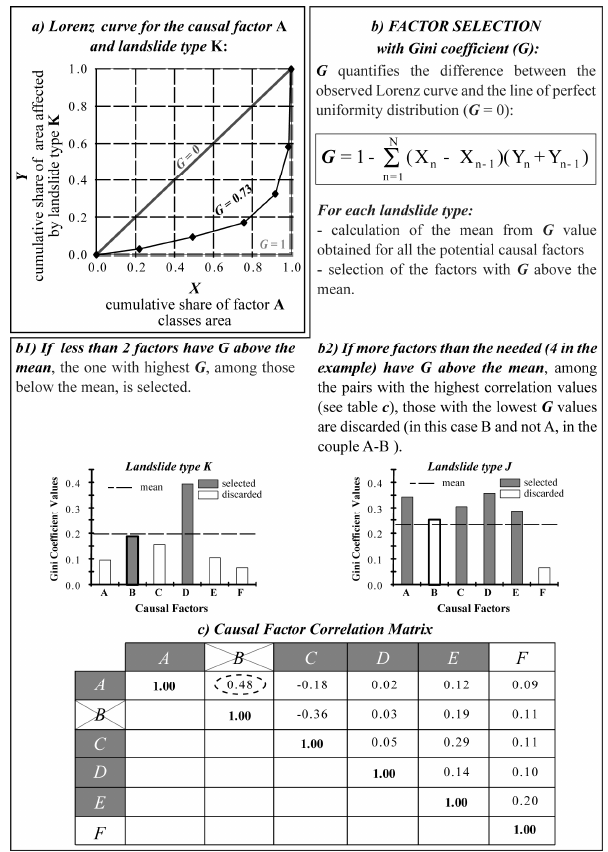
Figure 2: Factor selection procedure: a) Example of Lorenz curve representing the distribution of landslide within the different classes of a potential causal factor K ; the 1:1 solid line represents the homogeneous distribution of landslides with respect to factor classes, while the dotted line represents the perfect inequality distribution. b) Factor selection based on Gini coefficient value ( G ) with respect to the mean of the G values of all the considered factors. b1 ) Factor selection if only one factor has G value above the mean. b2) Factor selection if more factors than the needed number have G value above the mean. The degree of correlation between these factors (c) has to be considered, in order to discard, from the statistically correlated ones, those with lowest G values.